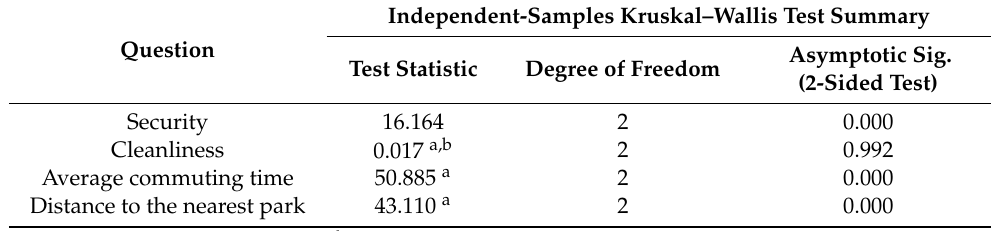
Table 3. The non-parametric-test results for the questions’ items with Likert scale responses.